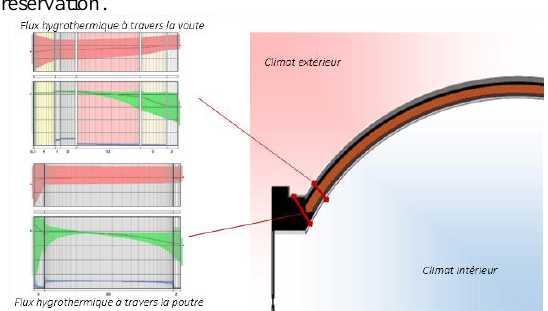
Figure 13. Hydro thermal 2D simulation to study the protection of the concrete